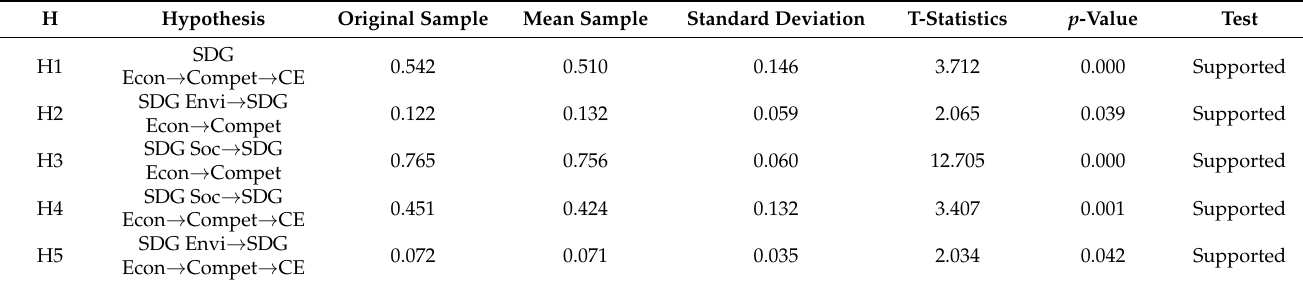
Table 5. Specific Indirect Effects.